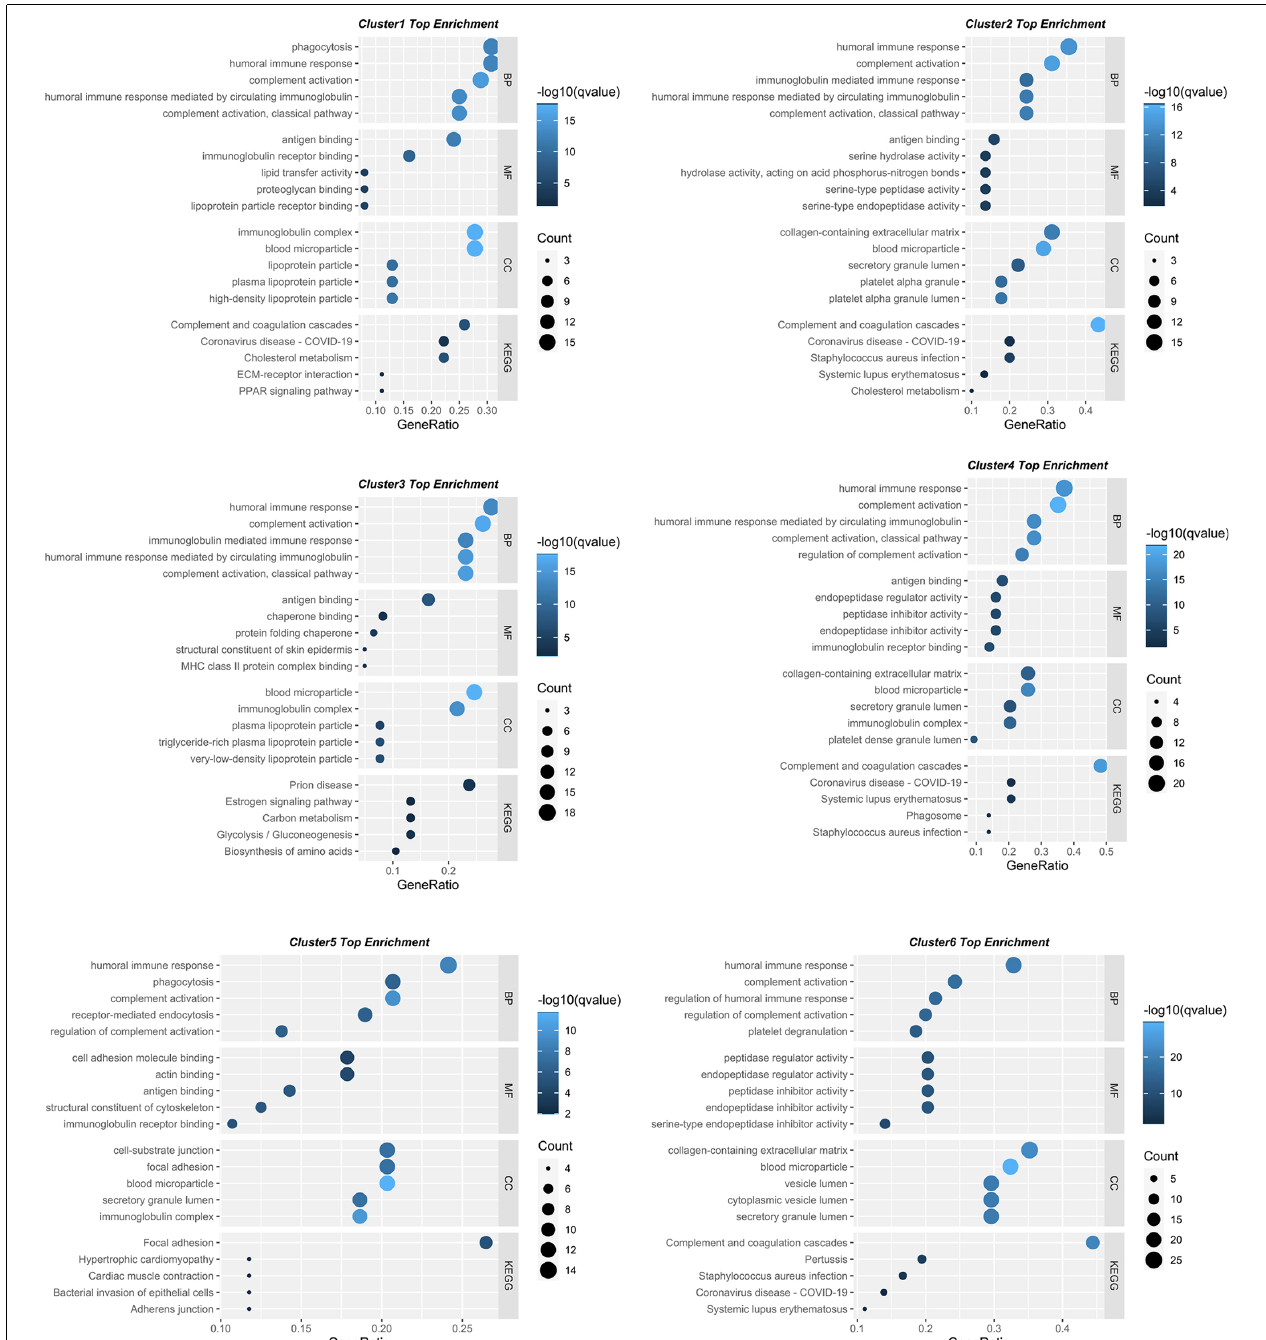
FIGURE 3 | Bubble plots showing the involvement of six protein clusters in different biological processes. The top five enriched KEGG pathways/GO terms for each cluster displayed in bubble plots. The dot size represents the number of proteins involved in each KEGG pathway/GO term, and the color gradient corresponds to the q -value-based statistical